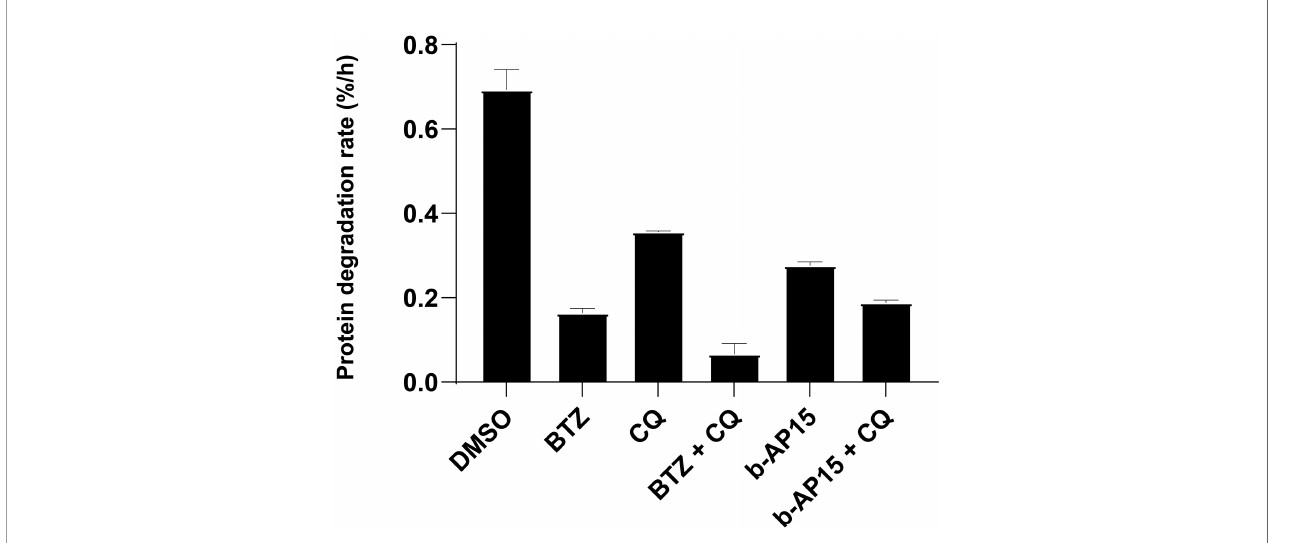
FIGURE 3 | b-AP15 inhibits proteasomal degradation. Degradation of long-lived proteins. HCT116 cells were pulse-labeled with 3 H-Phenylalanine and treated with the indicated drug or drug combination. The protein degradation rate is calculated from the acid-soluble radioactivity released into the media over 4 hours. The concentrations used are as follows: b-AP15 - 1µM, bortezomib (BTZ) - 1µM, chloroquine (CQ) – 40µM. Bars represent the mean of four replicates +/- SD; n=4. Pairwise comparisons except for BTZ vs b-AP15 + CQ (p = 0.77) are all signi fi cantly different (p <